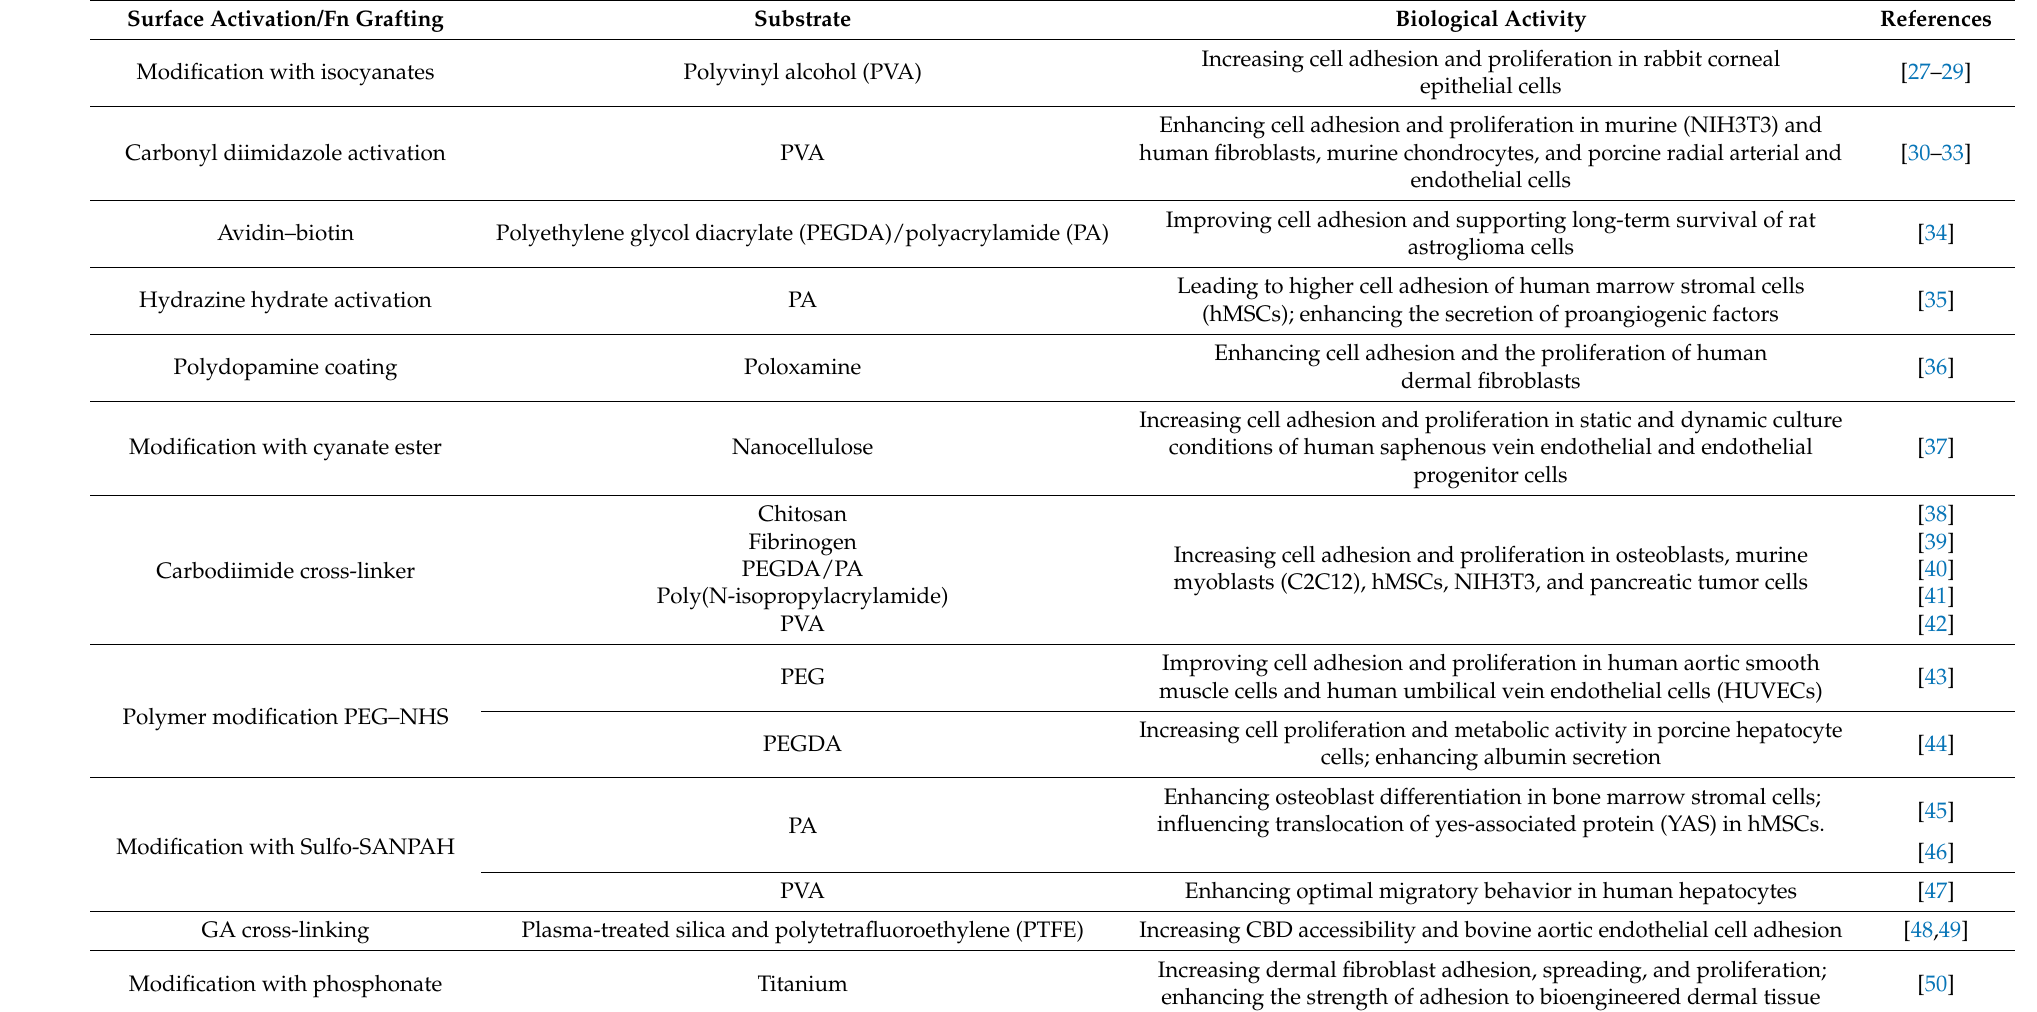
Table 1. Fn surface functionalization of different substrates using different strategies and related biological